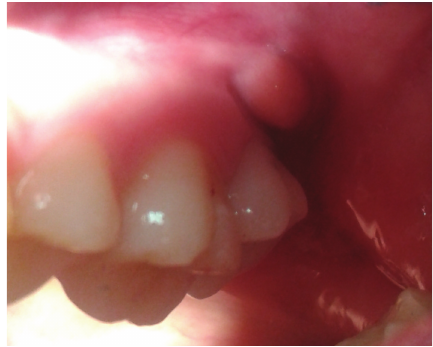
Figure2:Oralexaminationrevealedacyst-likeswellinginthedepth of the vestibule of tooth number